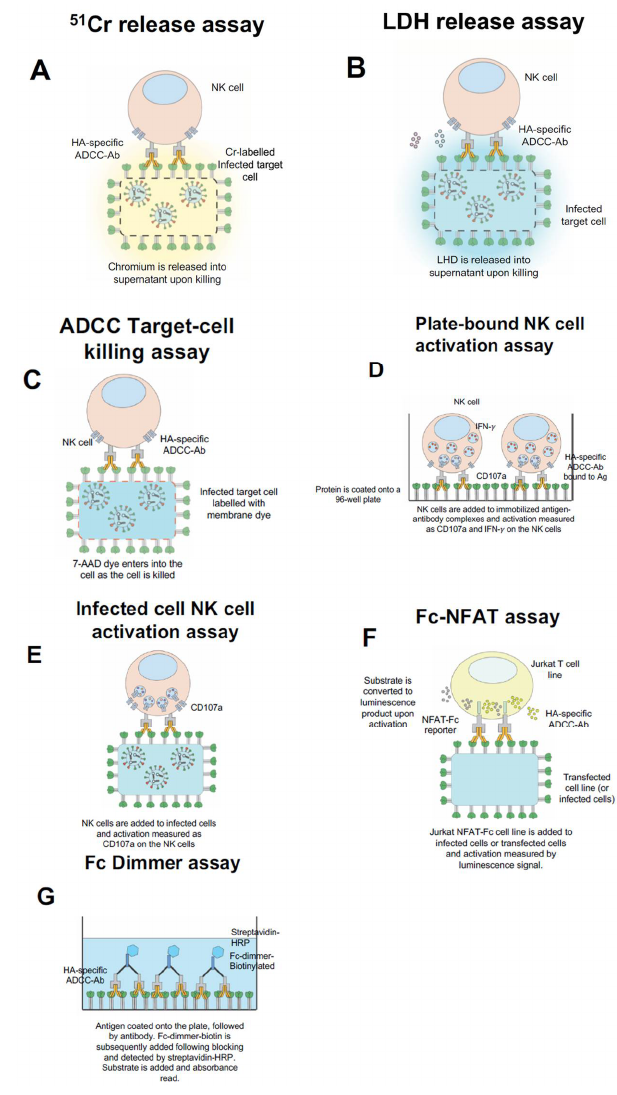
Figure 1. Common in vitro influenza Fc-receptor assays. 51 Cr-release assay, whereby infected target cells are labelled with chromium and exposed to PBMCs or purified NK cells with serum/Ig. As cells are killed the chromium is released into the supernatant ( A ). Lactate dehydrogenase (LDH) release assay, whereby infected target cells are exposed to PBMCs or purified NK cells with serum/Ig and the release of LHD is measured in the supernatant ( B ). ADCC Target Killing assay, whereby the infected target cells are labelled with a membrane dye, incubated with PBMCs or purified NK cells and with serum/Ig. The killing of the infected target cell results in the uptake of 7-AAD dye and subsequently can be detected by flow cytometry ( C ). Plate-bound NK cell activation assay, whereby the antigen is coated onto the well of a 96-well plate, subsequently serum/Ig is added, and then PBMCs or purified NK cells are added ( D ). Infected-cell NK cell activation assay, wherein the infected target cells are incubated with PBMCs or purified NK cells with serum/Ig ( E ). For both ( D , E ), NK cell activation is measured by the expression of surface CD107a and intracellular IFN- γ by flow cytometry. Promega Fc-FNAT assay, wherein Jurkat NFAT-Fc cell line is incubated with infected or transfected target cells with serum/Ig and substrate is added. Following activation, the substrate is converted to a luminescence product which can be measured in the supernatant ( F ). Fc dimmer assay, wherein antigen is coated onto a plate, followed by the addition of serum/Ig. Then Fc-dimmer-biotin is added and detected by the addition of streptavidin-HRP followed by substrate ( G